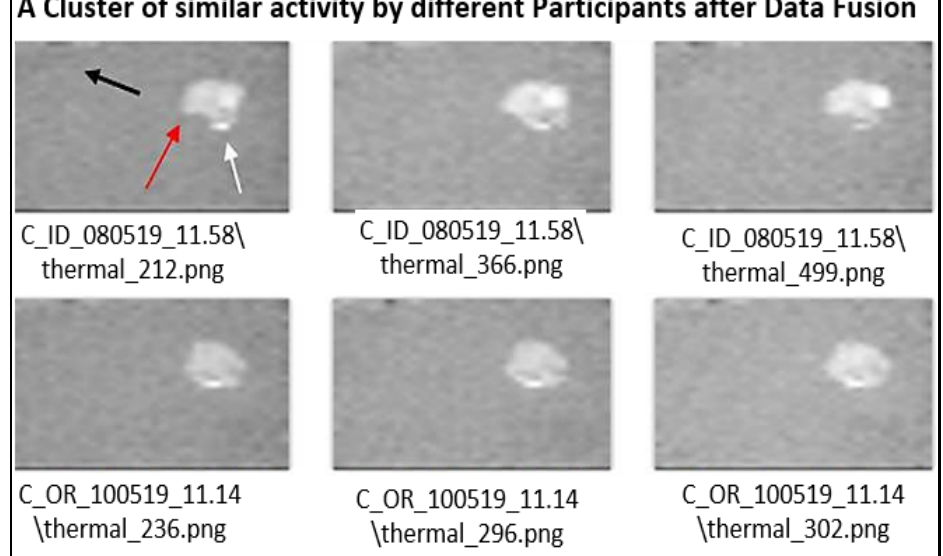
Figure 9. A cluster of data fusion output showing thermal blobs from two participants in a cluster with timestamps. The black arrow on ‘C_ID_080519_11.58 \ thermal_212.png’ points to the location of the lateral sensor, the red arrow points to the participant, and the white arrow points to the heat spot from tea/coffee cups. It is important to note that up to 1000 features (labelled n 0 to n 999 ) were extracted from each thermal image during the feature extraction process. Using these features, a PCA and scoring of the clusters performed between features n525 and n830 at 99% variance coverage indicated a regression coefficient (r) of 0.98 and 1.00 for Clusters 2 and 12, respectively, as presented in Figure 10 .